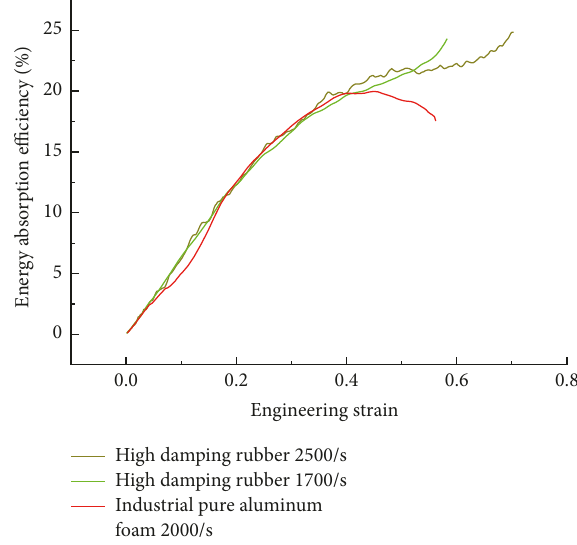
Figure 13: Comparison of curve of energy absorption